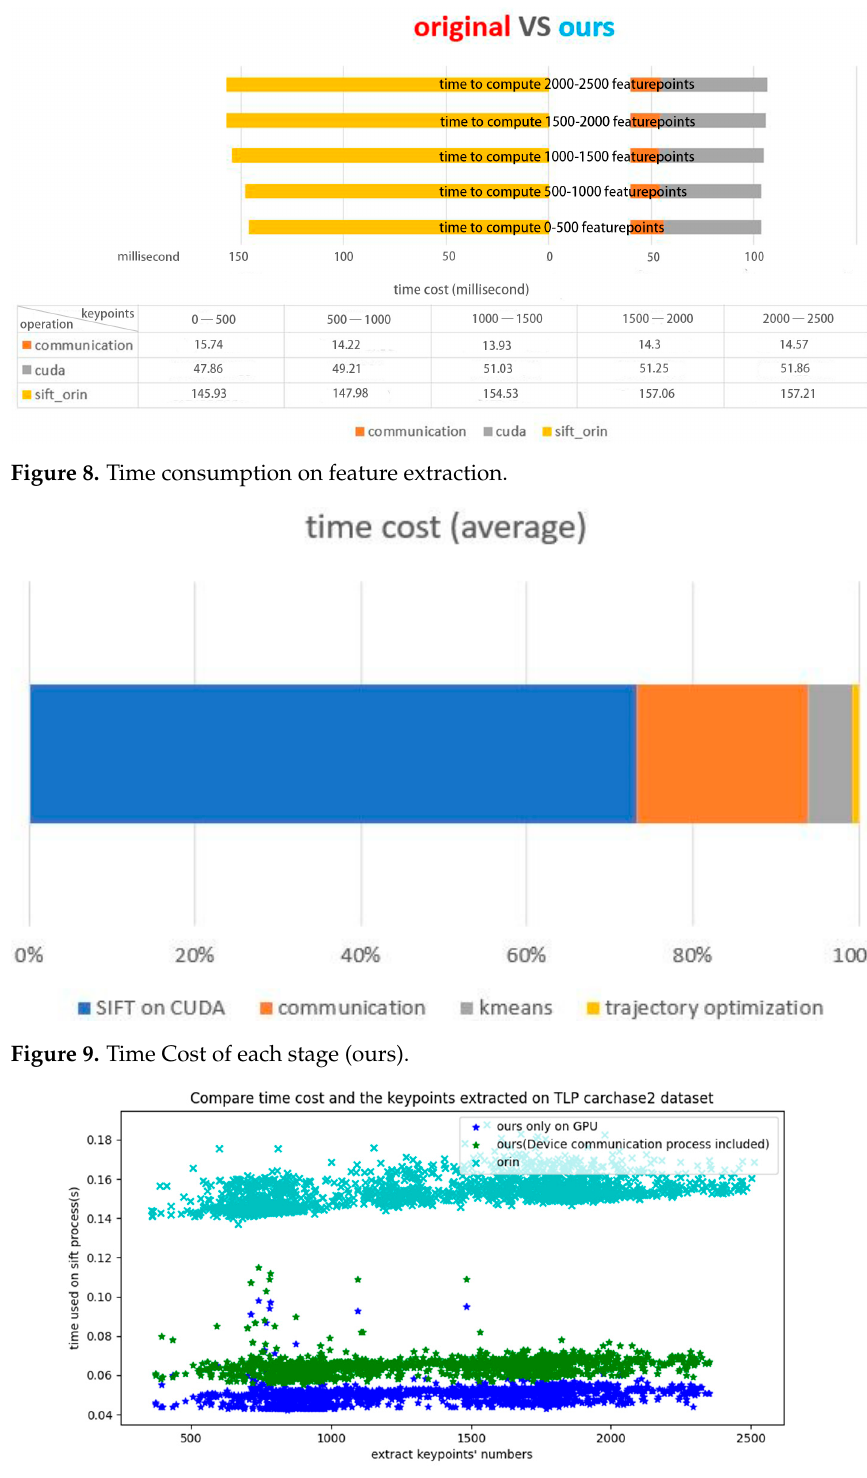
Figure 10. Time consumption on feature extraction in detail.